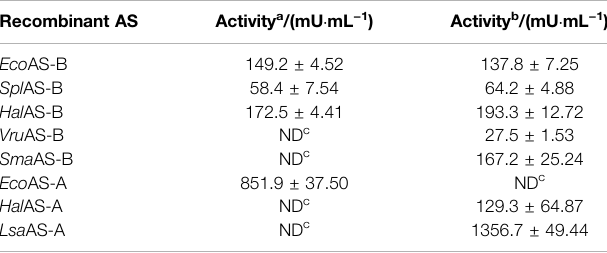
TABLE 1 | Activities of recombinant AS expressed in E. coli BL21 (DE3) and B. subtilis WB600. Recombinant